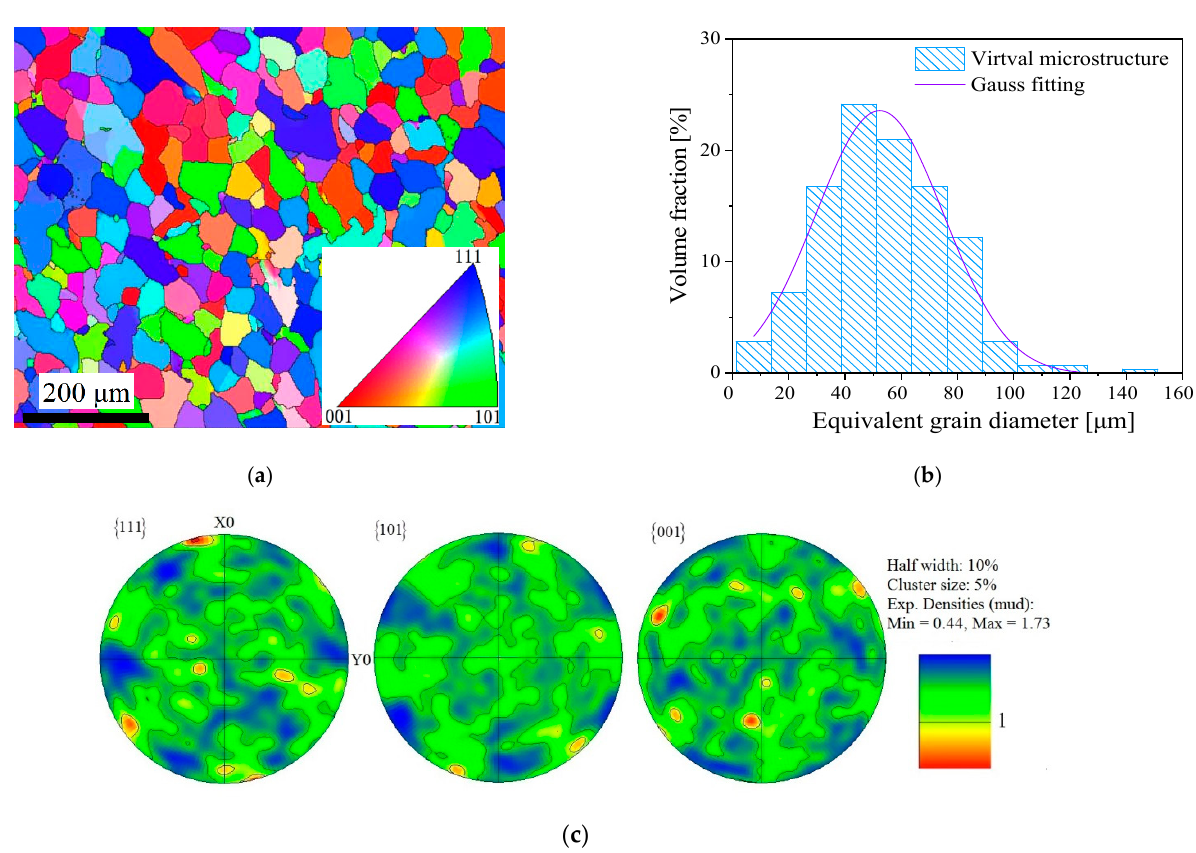
Table 1. Chemical compositions and mechanical properties of polycrystalline aluminum.